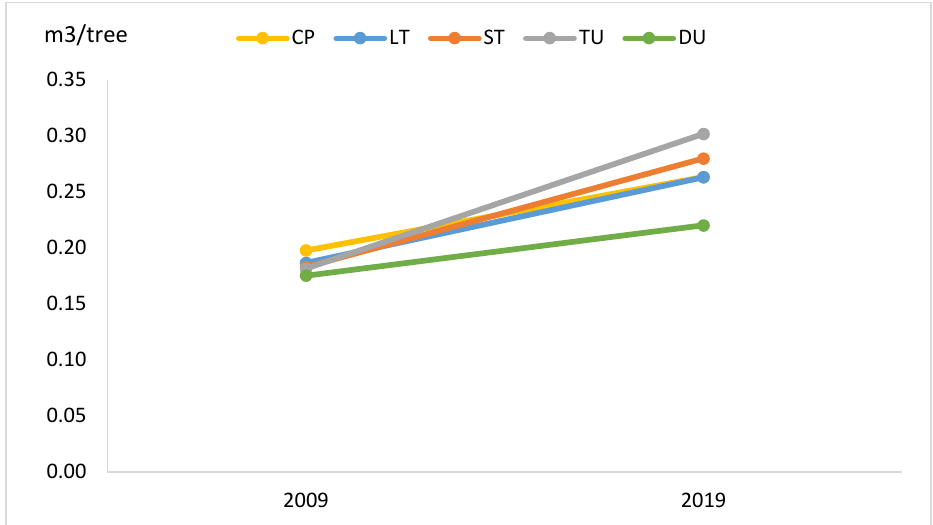
Figure 5. Changes in the unitary volume of the mean tree per treatment between 2009 and 2019.